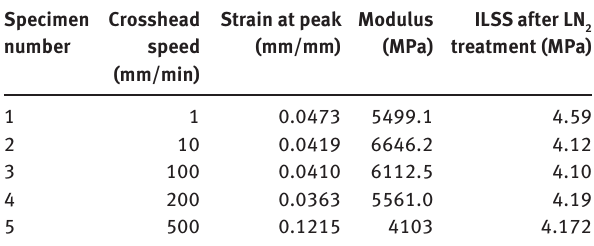
Table 2 ILSS values and modulus of LN